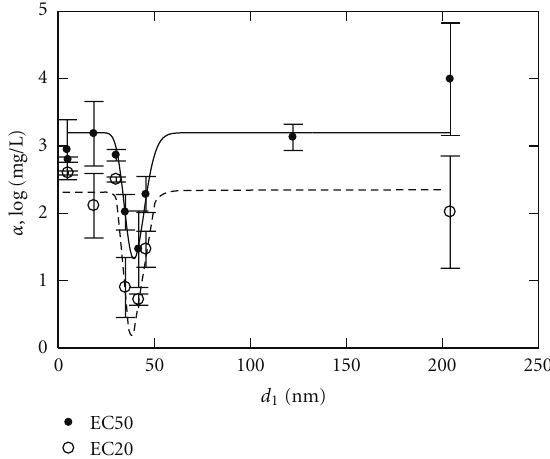
Figure 4: Critical specific growth ( α ) as a function of primary particle size of TiO 2 in terms of EC20 and EC50. Lines are a five-parameter modified log normal empirical fitting (7) from SigmaPlot ver. 9.01 for EC20 (dotted) and EC50 (solid). Error bars are ± 1 standard deviation. Experimental conditions: initial algae concentration = 1 . 4 ± 0 . 9 × 10 6 cell/mL, test duration = 4 days, and initial test volume = 200